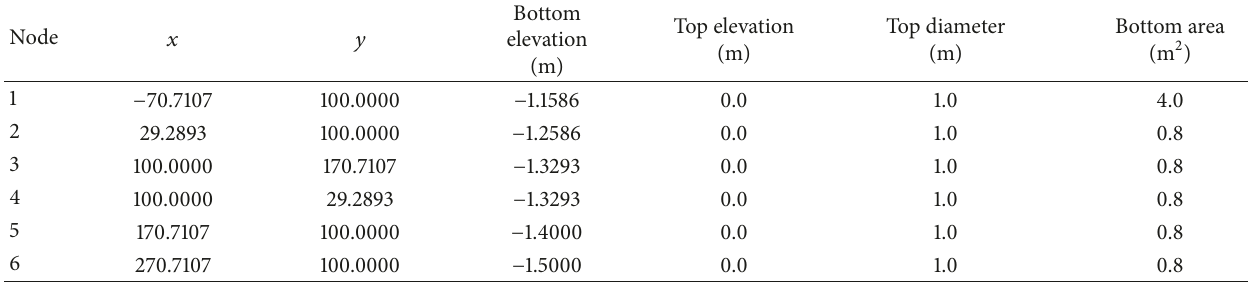
Table 3: Node characteristics of network.